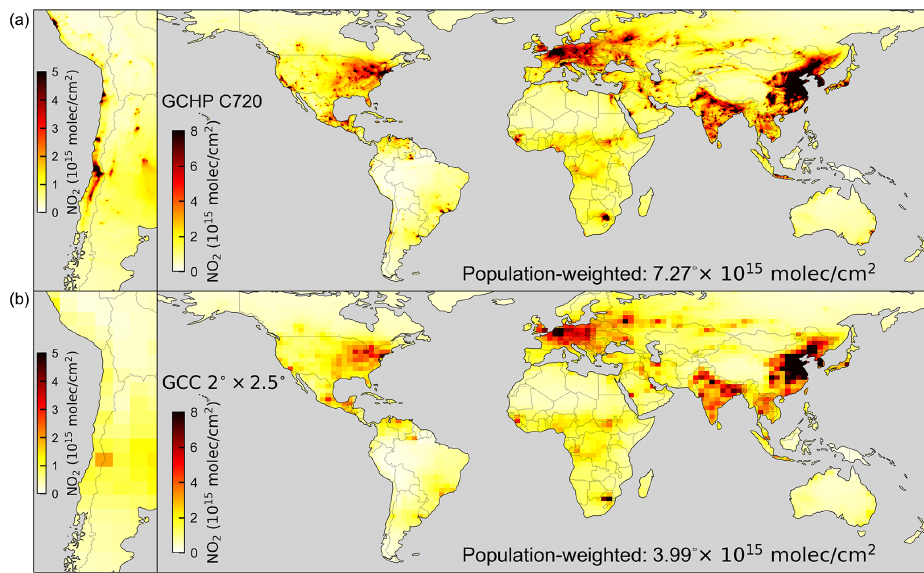
Figure 7. Simulations of tropospheric NO 2 columns using GCHP at C720 resolution (a) and GEOS-Chem Classic (GCC) at 2 ◦ × 2.5 ◦ resolution (b) . Both simulations used version 13.2.1 for the period 9–15 April 2021 following a 1-week